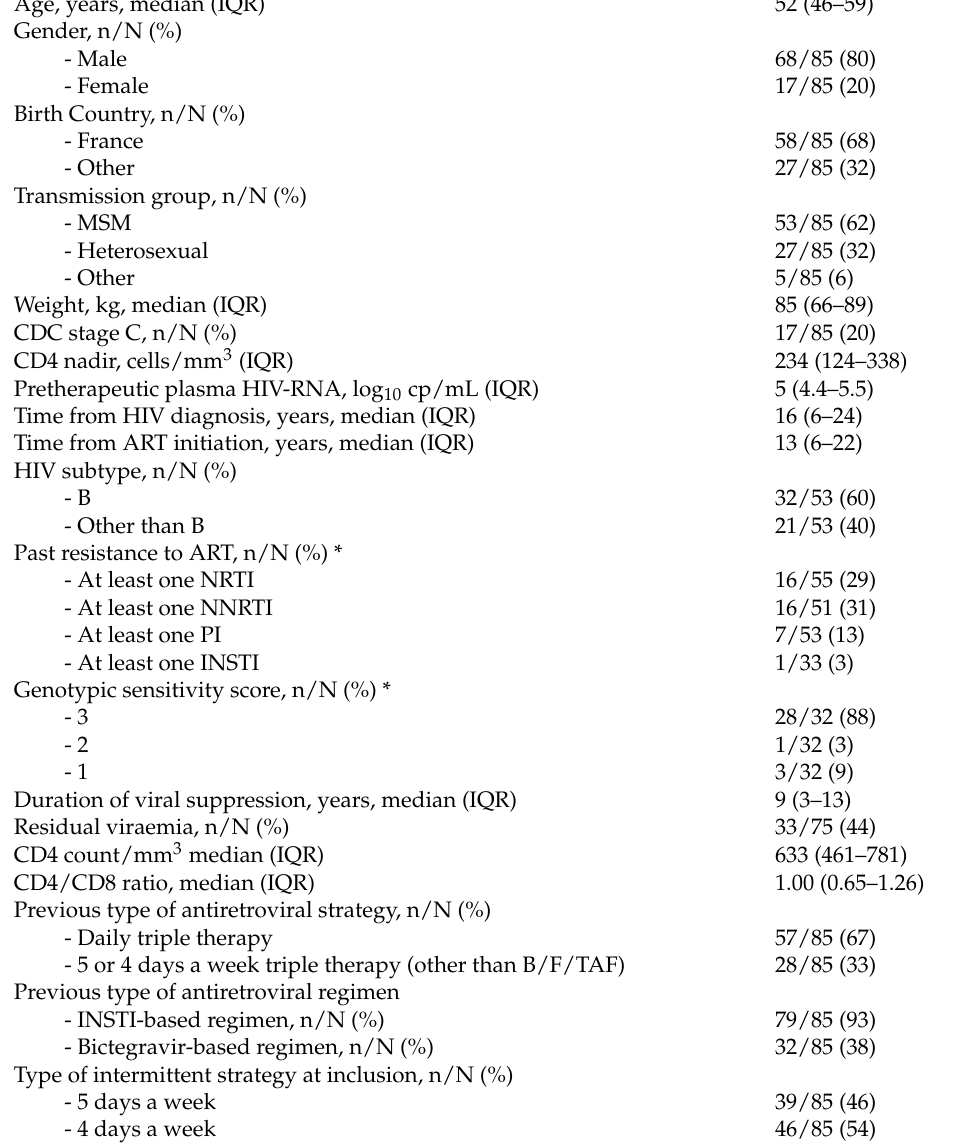
Table 1. Patient characteristics at baseline (N =